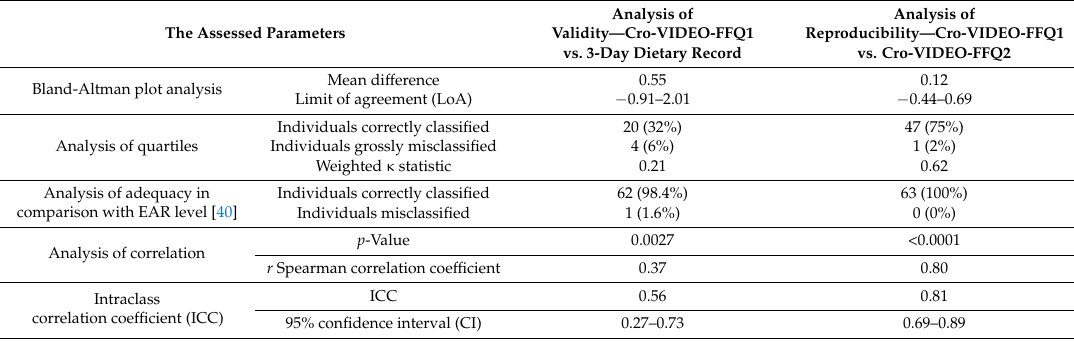
Table 4. The validation of the Cro-VIDEO-FFQ questionnaire including assessment of validity and